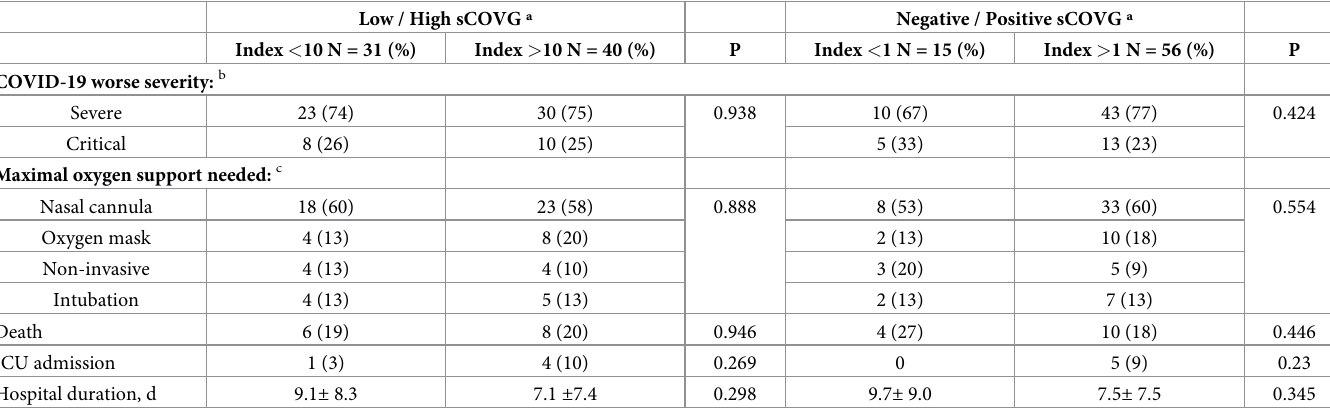
Table 3. Disease outcomes by SARS-CoV-2 IgG antibody levels among the antibody cohort. Low / High sCOVG ª Negative / Positive sCOVG